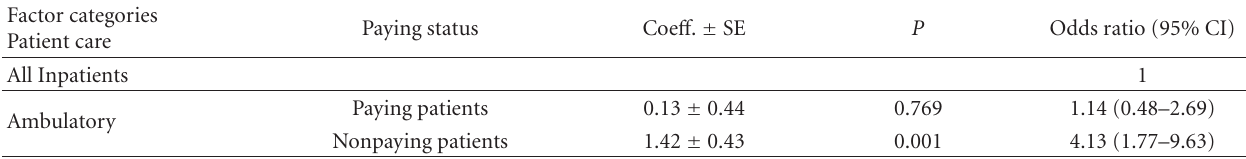
Table 5: Adjusted odds ratio of endophthalmitis with ambulatory patient care in paying and nonpaying